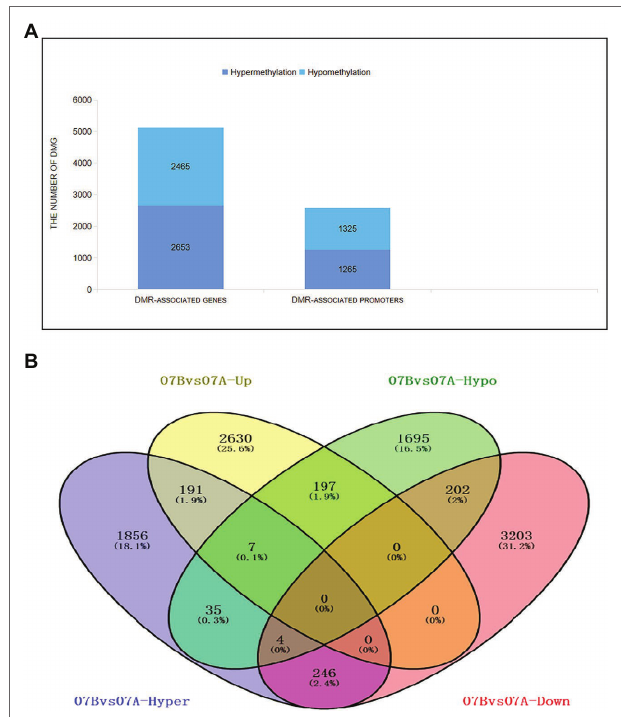
FIGURE 4 | Distribution of differentially methylated genes. (A) Distribution of differentially methylated genes in DMR-associated genes/promoter groups between 07-113A and 07-113B. (B) Venn diagram showing overlaps between the differential methylated genes (DMGs) and differentially expressed genes (DEGs). 07A, 07-113A; 07B,